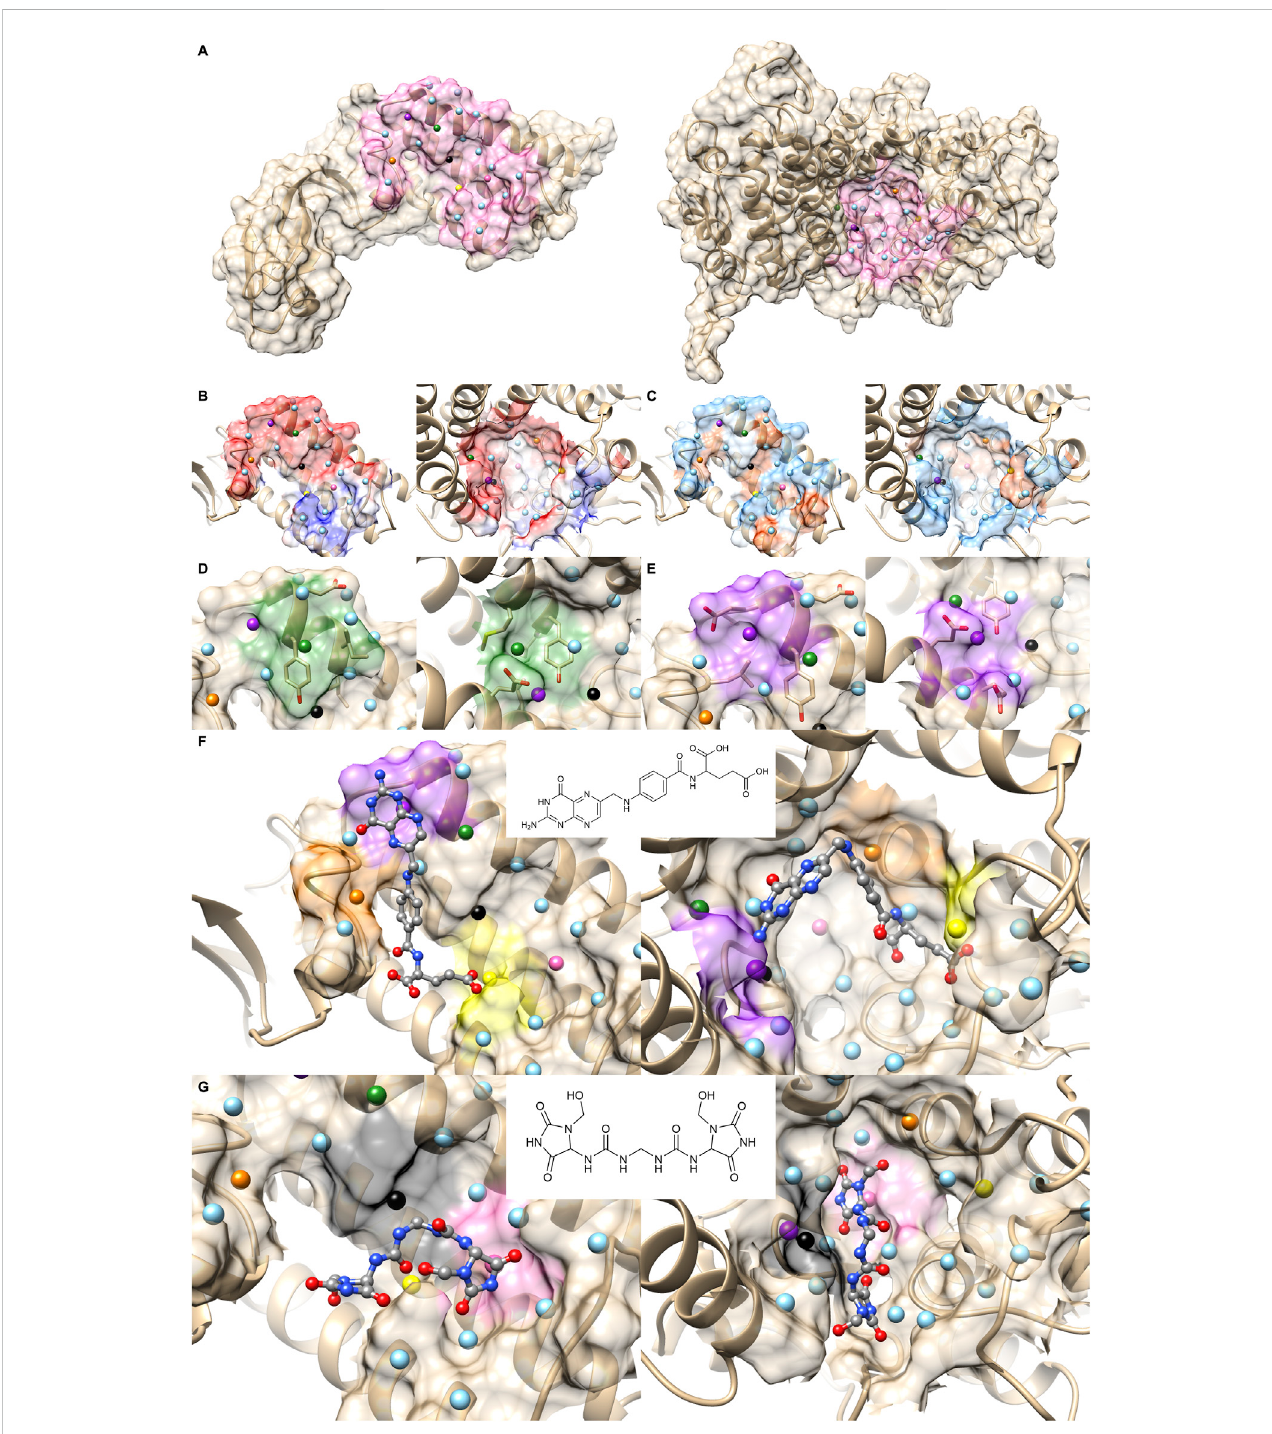
FIGURE 6 Comparison with 1TUEAB and 4GQ6AB, which are clustered in the PPI Score-based clustering. (A) Molecular surfaces of replication protein E1 (2P2I ID: 1TUEAB, left) and menin (2P2I ID: 4GQ6AB, right) and seed points (center of patches, sky bluesphere). The interface extracted is highlightedas pink.The seed points of corresponding patch pairs identi fi ed by PPI-Surfer are colored in green, purple, orange, yellow, black, and pink. (B) The electrostatic potential mapped on the PPI surface. The color changes from red (negative) to blue (positive). (C) Hydrophobicity mapped on the PPI surface. The color changes fromskyblue(hydrophilic)toorange(hydrophobic). (D) Patchpairsthathavetheclosestdistancefrom1TUEABand4GQ6AB.1TUEABpatch#8and4GQ6AB patch #21. The seed points are shown in green. Surface regions within 6 Å to the seed points are colored also in green. (E) Patch pairs that have the second closest distance from 1TUEAB and 4GQ6AB. 1TUEAB patch #12 and 4GQ6AB patch #22. The seeds and the surface regions are colored in purple. (F, G) Predicted binding poses of folic acid panel (F) and imidazolidinyl urea panel (G) on the PPI surfaces of 1TUEAB and 4GQ6AB. Two-dimensional structures of the compounds are shown at the middle of the